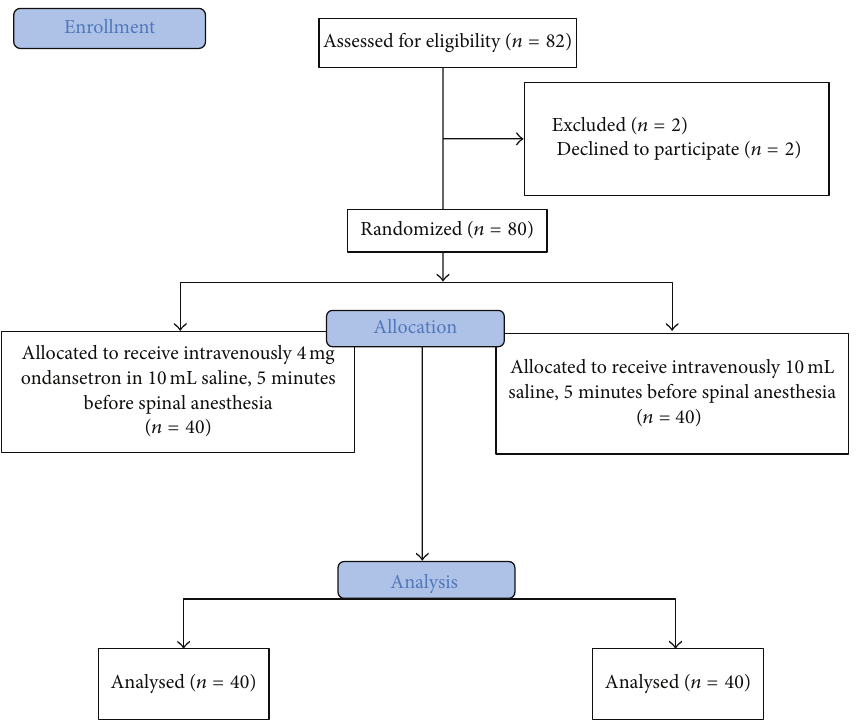
Figure 1: Flowchart of parturients enrolled in the study.